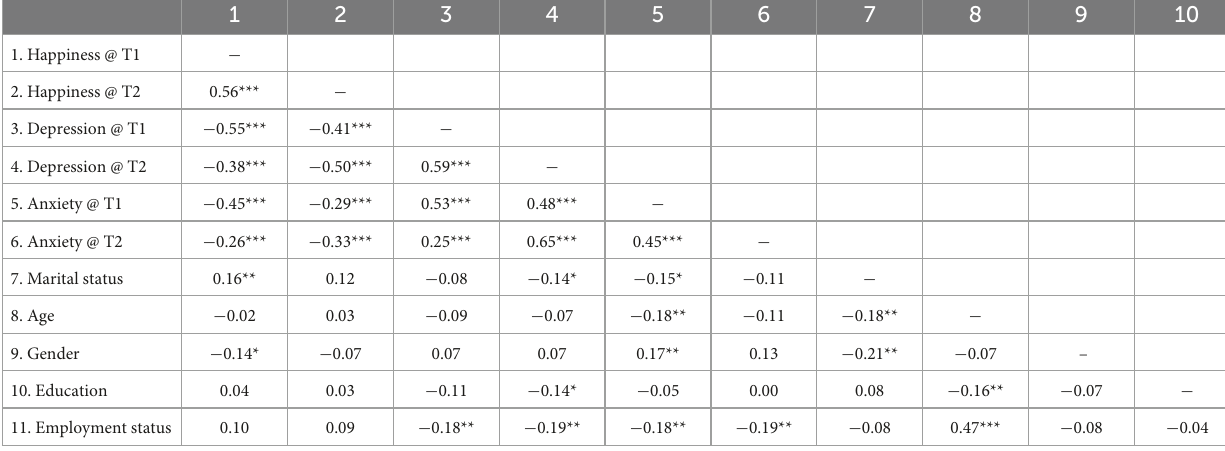
Figure 3 for a graphic representation of depression symptoms by pre-/post-pandemic declaration in predicting